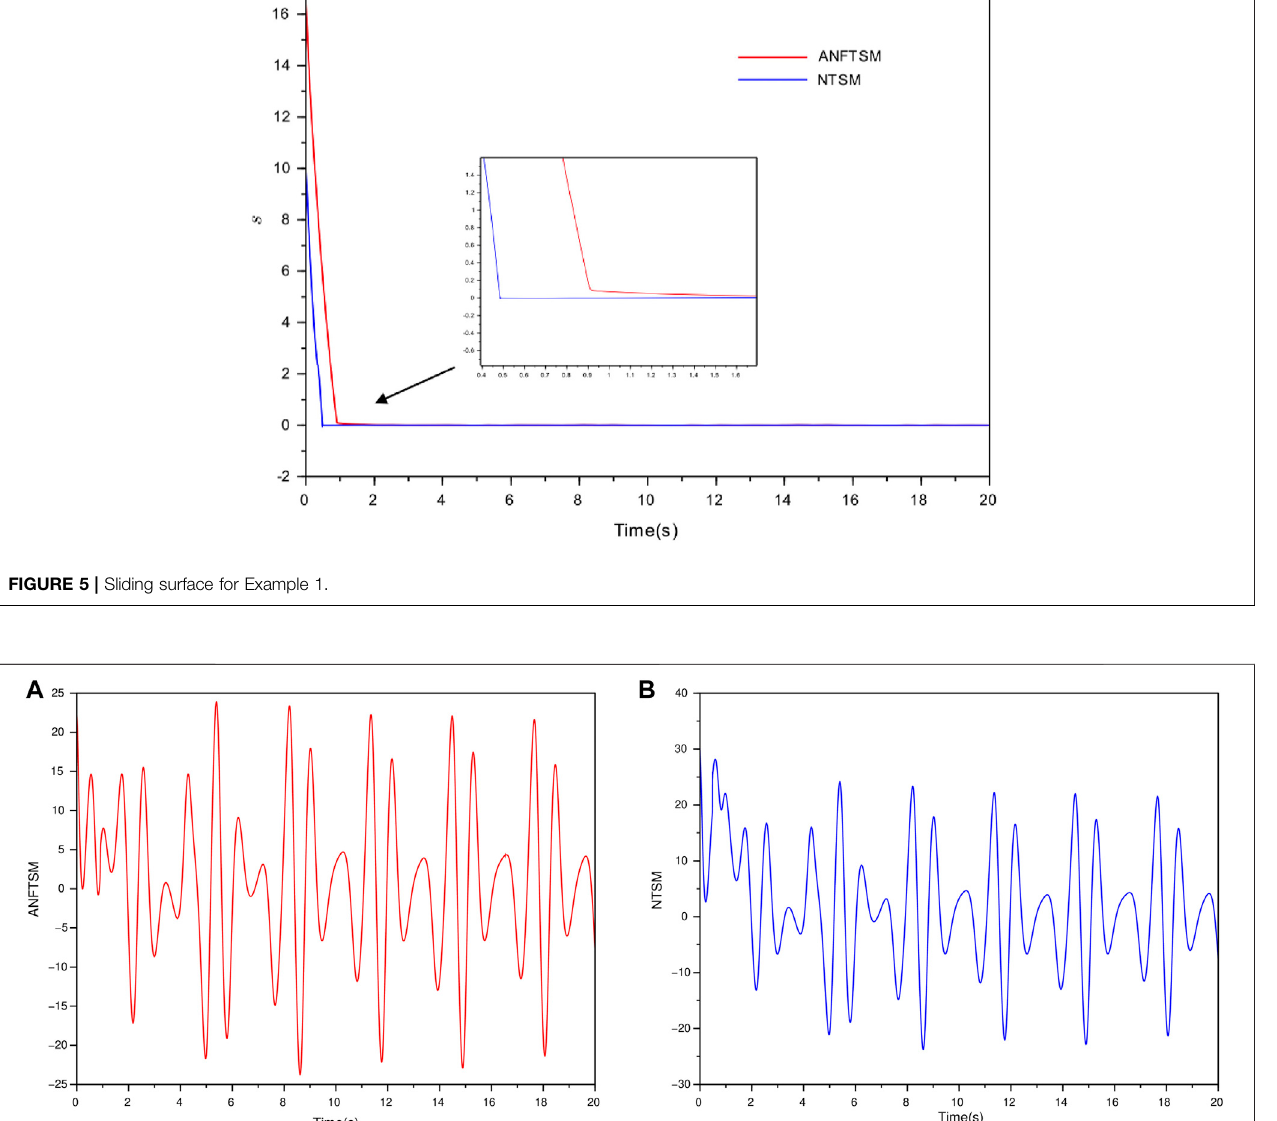
Frontiers in Applied Mathematics and Statistics |